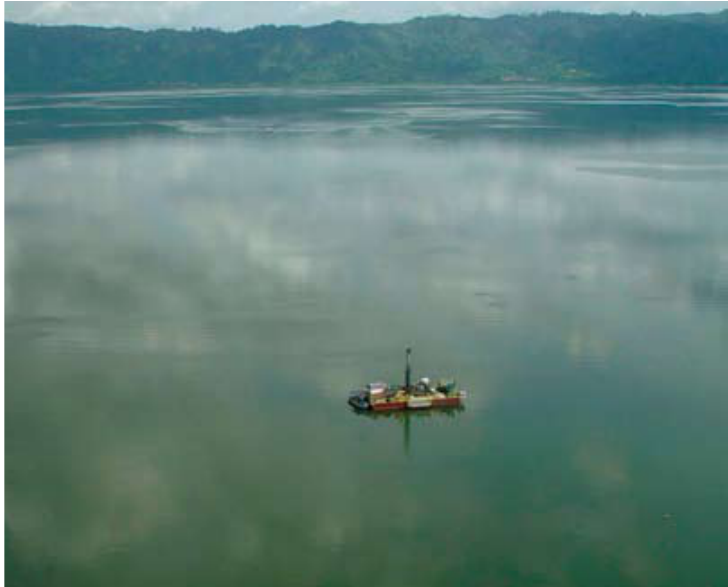
Figure 1. The GLAD-800 lake drilling system on Lake